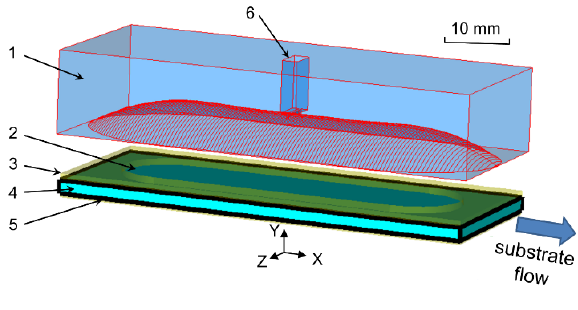
Figure 1. Design of open mw resonance structure for MRI DNP. 1 – concave mirror (copper), 2 – aqueous sample, 3 – fixture (brass), 4 – cover plate (sapphire), 5 – plain mirror (copper), 6 – waveguide port. Aqueous solution flow direction is indicated by the “substrate flow”